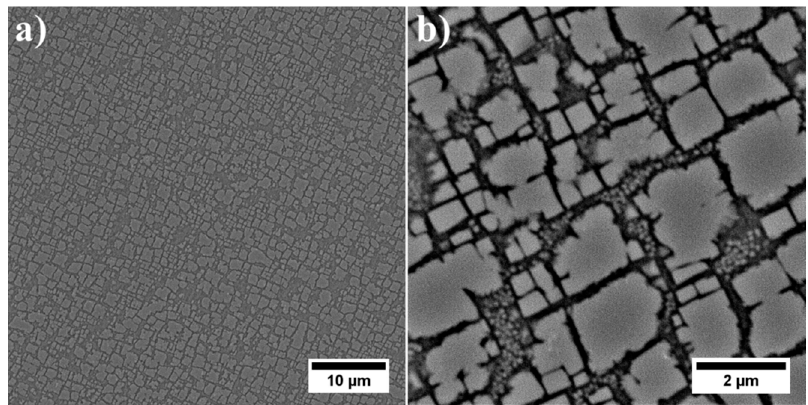
Figure 2. Microstructure of γ ' precipitates in dendritic region: ( a ) distribution of large secondary γ ' precipitates; ( b ) tertiary γ ' precipitates in channels of γ matrix.